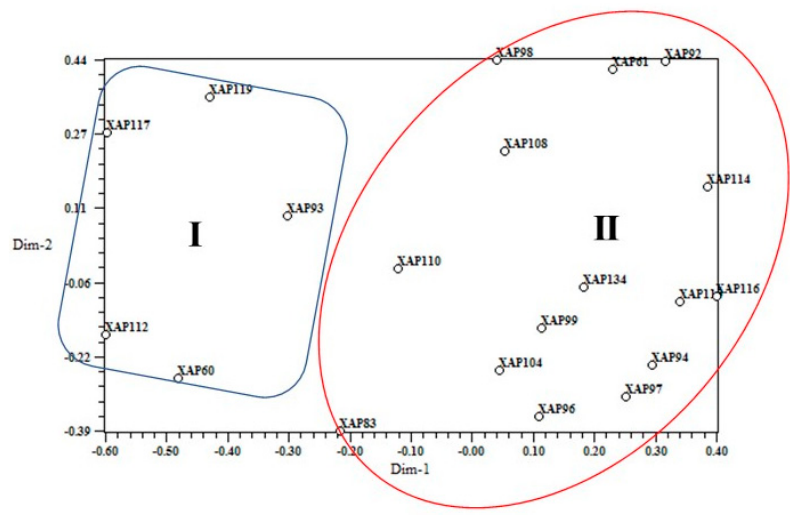
Figure 3. Dendrogram showing genetic diversity amongst Xap isolates on the basis of SSRs.